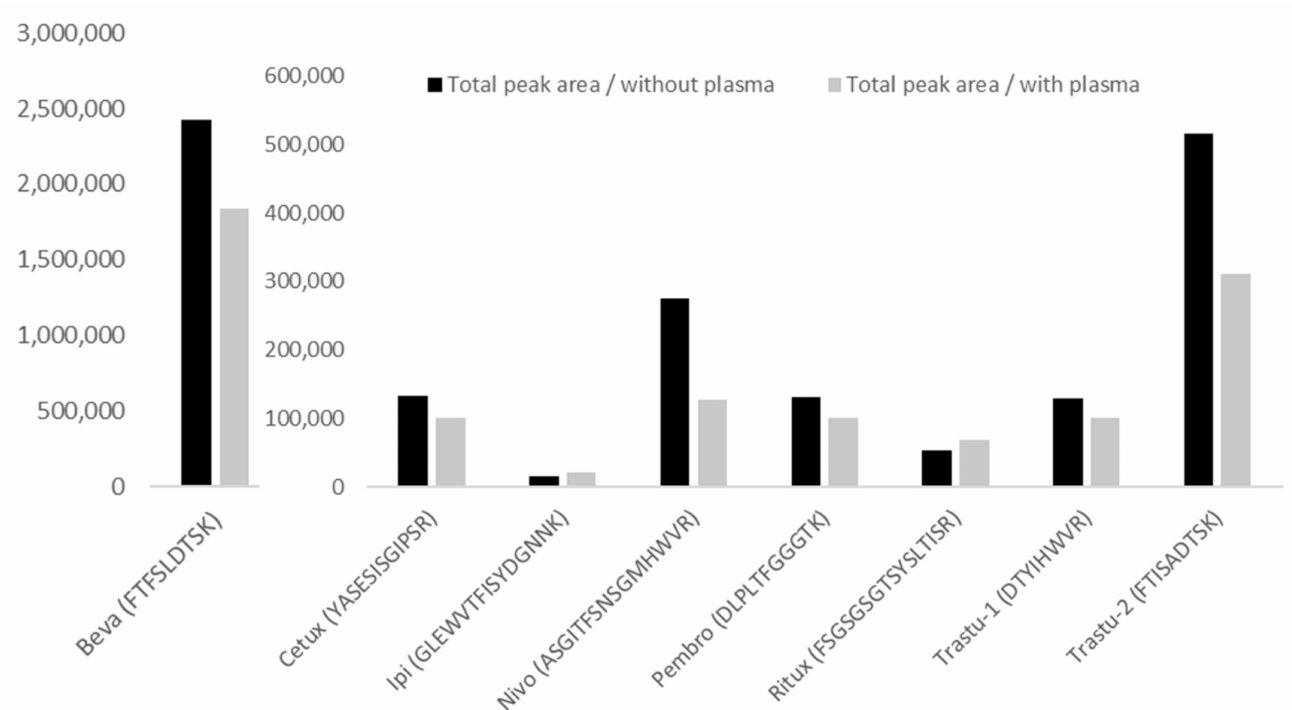
Figure 3. Matrix effect for the different mAbs. Black histograms represent the total area measured for the peptide (mean of MRM transitions) in the absence of plasma, while the grey histograms represent the total area measured for the same peptide and same concentration (mean of MRM transitions) in the presence of plasma. Samples, without and with plasma, were analyzed in 6 replicates from a pool of human plasma samples. CV% between replicates were consistent and below 9% in the absence of matrix, and below 11% in the presence of matrix, except for Nivo where CV% was 19% in the presence of